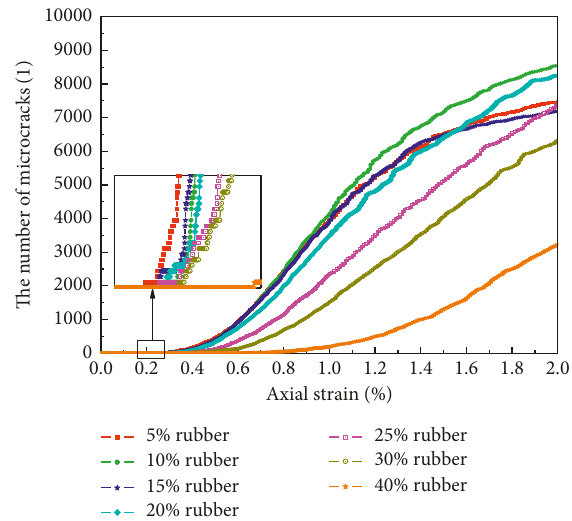
Figure 11: The initiation and evolution of microcracks.